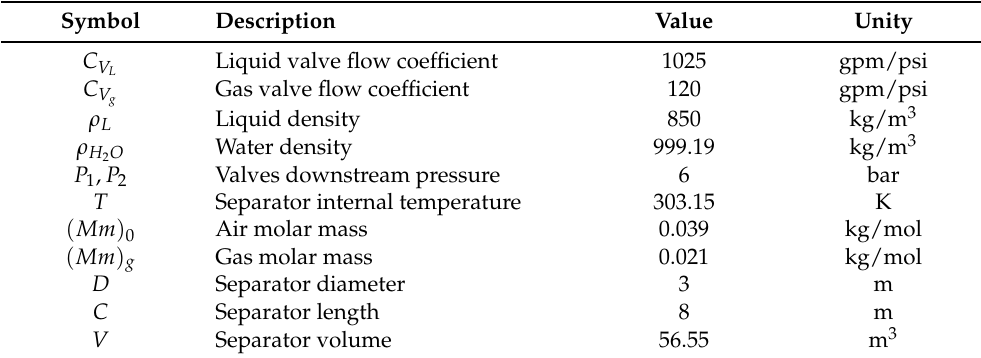
Table 1. Biphasic oil separator constants.